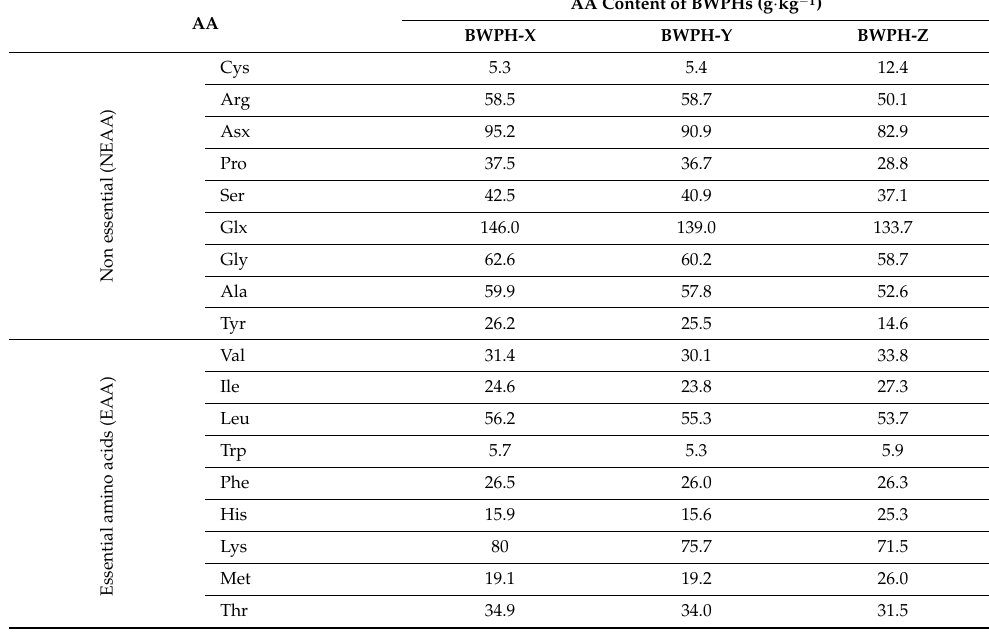
Table 2. Amino acid (AA) profiles of blue whiting ( Micromesistius poutassou ) protein hydrolysates (BWPHs g · kg − 1